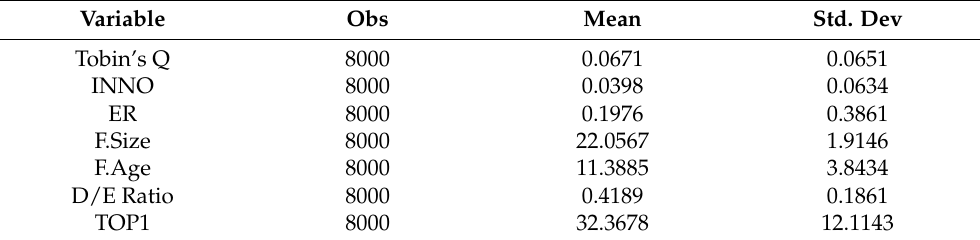
Table 1. Descriptive Statistics.